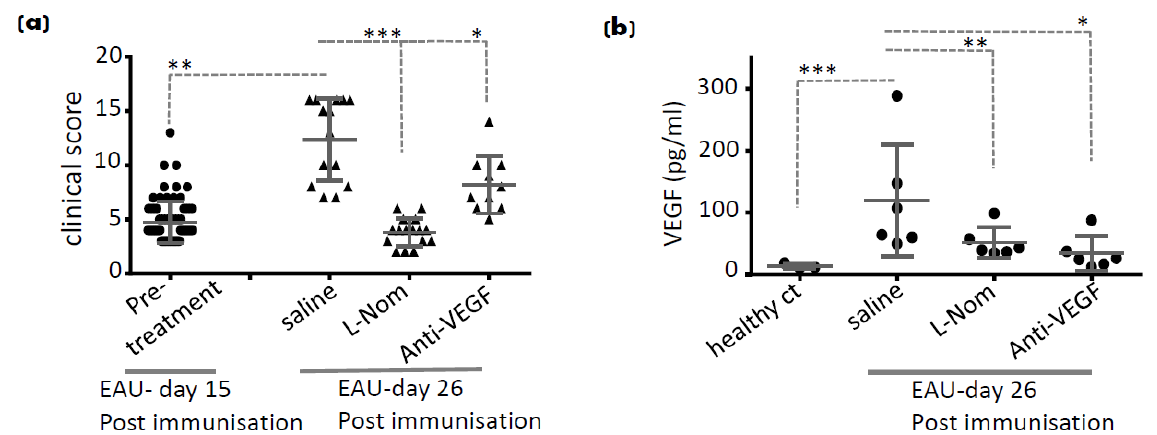
Figure 3. Disease suppression and VEGF downregulation. ( a ) Clinical score of EAU mice (C57Bl/6) on day 15 post- immunisation and pre-treatments. Clinical score of EAU mice at the end point on day 26 post-immunisation. Mice were treated intravitreally with 1–2 µ L of L-nomacopan (L-Nom; only targeting LTB4, 20 mg/mL), saline or anti-VEGF (5 mg/kg, Ultra-LEAF™ Purified anti-mouse VEGF-A Antibody, 2G11-2A05, Biolegend) on day 15 and 18 post-immunisation. ( b ) VEGF levels (pg/mL) were detected in vitreoretinal space of corresponding EAU mice in (a) and compared to the healthy control mice. Each bar was drawn based on the mean value ± SD of each score ( n = 8–17 mice). Unpaired t -test P values compared to vehicle. * p < 0.05, ** p < 0.01, *** p <